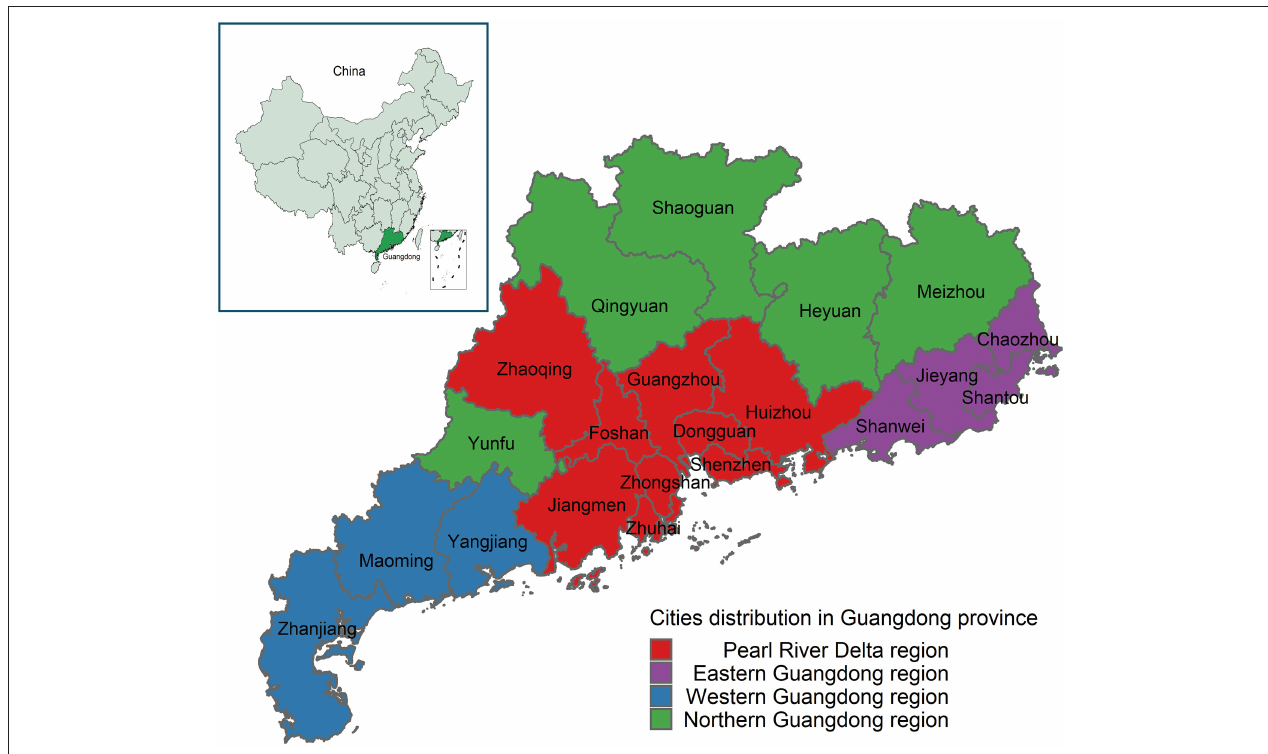
FIGURE 1 | Geographical locations of the study area. Guangdong, which located in southern China, includes 21 cities, and divided into four regions. The Pearl River Delta region includes Guangzhou, Dongguan, Shenzhen, Huizhou, Zhaoqing, Foshan, Zhongshan, Zhuhai, and Jiangmen; Eastern Guangdong includes Shanwei, Jieyang, Shantou, and Chaozhou; Western Guangdong includes Yangjiang, Maoming, and Zhangjiang; Northern Guangdong includes Yunfu, Qingyuan, Shaoguan, Heyuan, and